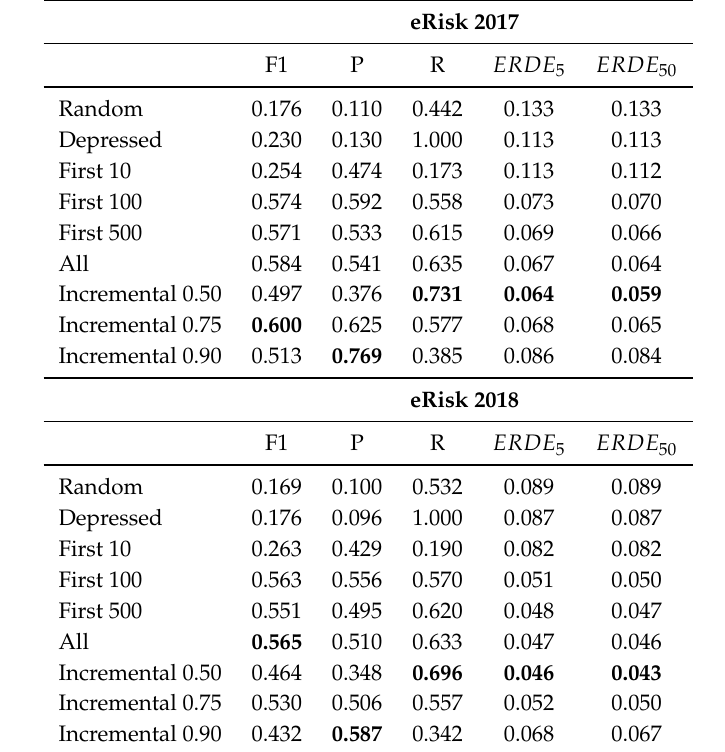
Table 2. Comparison of classifiers. Classification and early detection